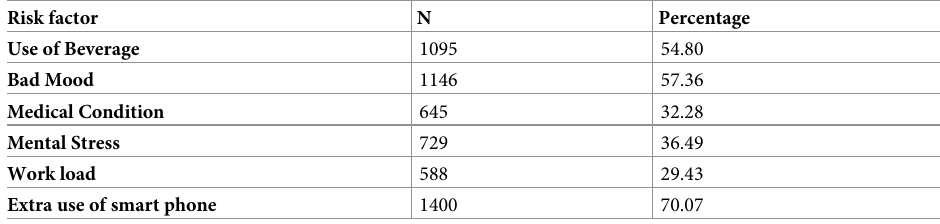
Table 9. Associated risk factors of sleep disorder (N = 1998).